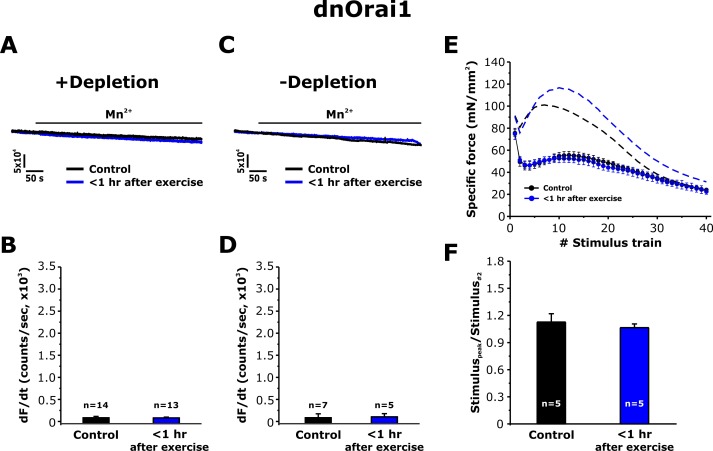
Effect of exercise on the maximum rate of Mn2+ quench and contractile force in dnOrai1 mice.Data were obtained in FDB fibers and EDL muscles from non-exercised dnOrai1 mice and dnOrai1 KO mice < 1 hr after acute treadmill. (A) Representative traces of fura-2 fluorescence during application of 0.5 mM Mn2+ recorded in FDB fibers following store depletion with 1 μM TG + 15 μM CPA (+depletion). (B) Representative traces of fura-2 fluorescence during application of 0.5 mM Mn2+ recorded in FDB the absence of store depletion (-depletion). (C–D) Quantitative analysis of the maximum rate of Mn2+ quench under store-depleted (C) and non-depleted (D) conditions in FDB fibers. (E) Quantitative analysis of the time course of specific force during 40 consecutive, high-frequency stimulus trains in EDL muscles. (F) Quantitative analysis of the ratio between the maximum peak-specific force produced during the 40 stimulus trains and that of the 2nd stimulus train in EDL muscles. Numbers (n) reflect the number of FDB fibers or muscles analyzed. Number of mice used: dnOrai1 control, n = 4; dnOrai1 exercised, n = 4; *p<0.05. Data are shown as mean ± SEM.